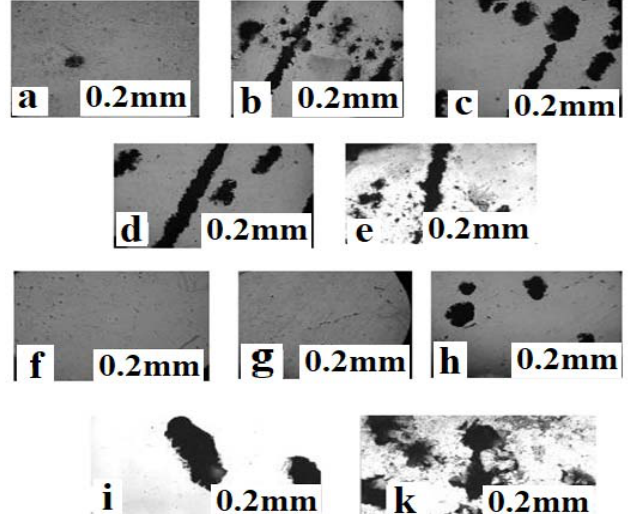
Fig. 17. Microscopic images of aging samples for 4 hours at different aging temperatures. (a, g) 500, (b, h) 550, (c, i) 600, (d, j) 650, (e, k) 700, (f, l) 750 °C, where (a, b, c, d, e, f, acceleration test) and (g, h, i, j, k, l, immersion test).